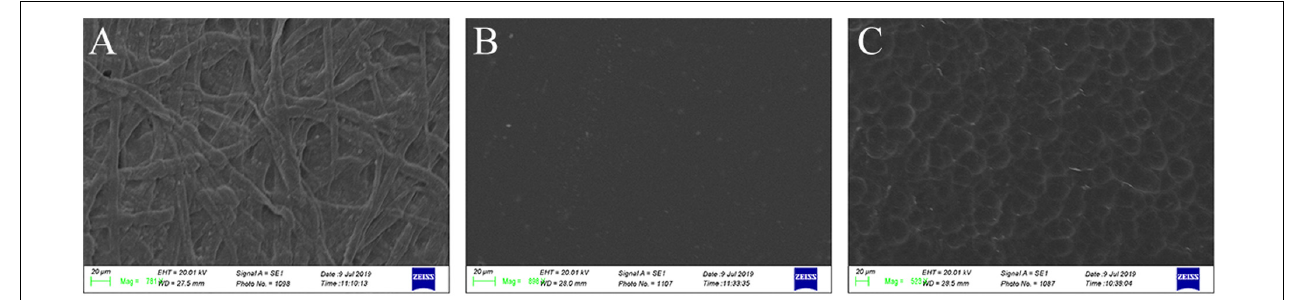
FIGURE 2 | SEM images of polyethylene-coated parchment (designated as A ), polyethylene-coated nylon (designated as B ), and greaseproof paper (designated as C ). In (A,C) , package materials the presence of fibers and micro-pores is evident. By contrast, B package material showed a smooth, plane, and homogeneous surface without holes or micro-pores able to entrap